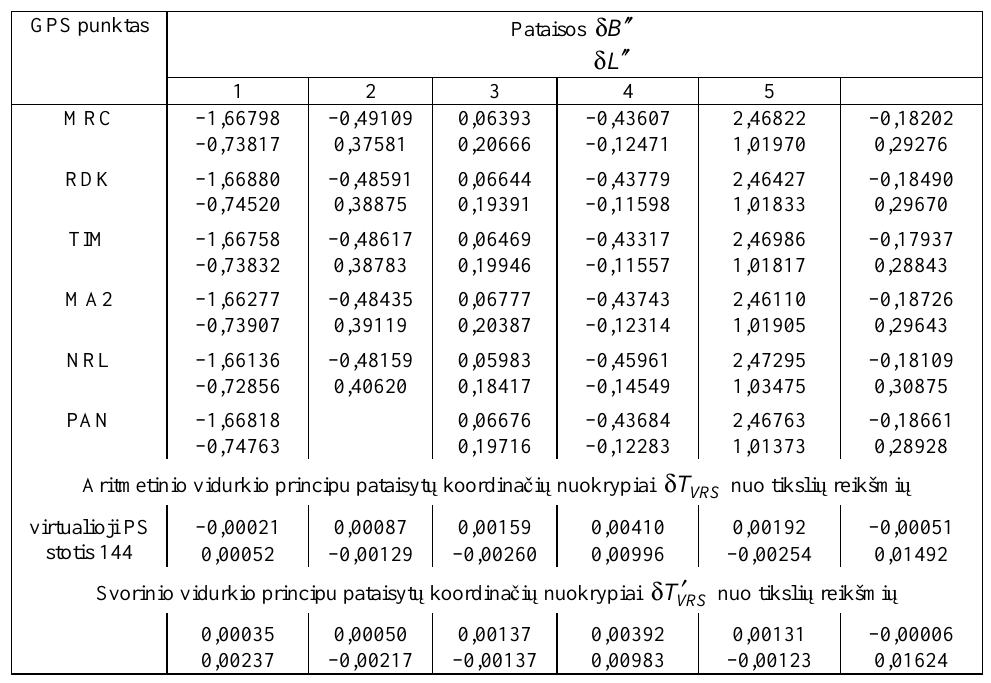
Table 2. Corrections